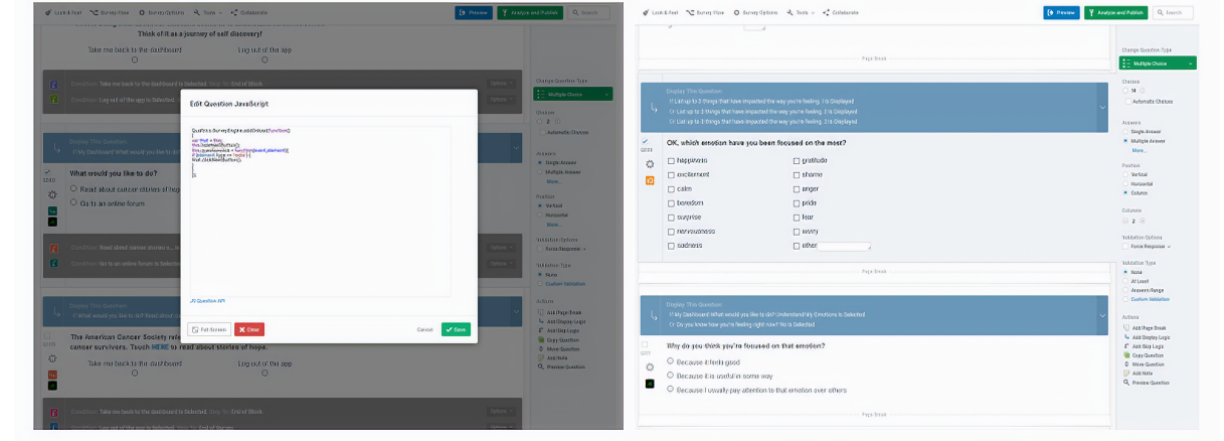
Figure 4. Screenshots of the custom JavaScript and using the multiple-choice question type to create intervention content in the iCanThrive